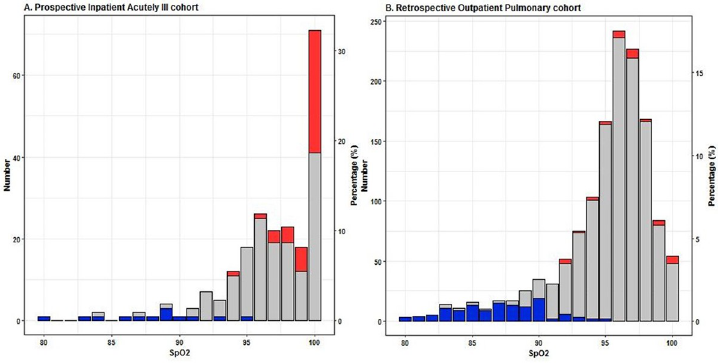
Fig 4. Stacked bar plots of the number and percentage of PaO 2 values at every SpO 2 value. A. Prospective Inpatient Acutely ill cohort (PIA cohort) and B. Retrospective Outpatient Pulmonary cohort (ROP cohort). The left y-axis represents the number of data points and the right y-axis represents the percentage of data points per SpO 2 value of the total number of measurements in the whole cohort. PaO 2 values are divided into three groups: < 60 mmHg (blue), 60– 125 mmHg (gray) and > 125 mmHg